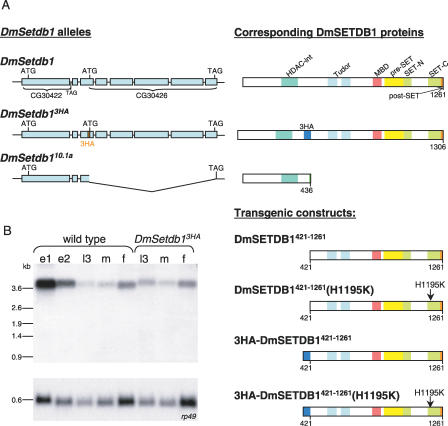
Schematic of the DmSetdb1 Alleles and Expression Profile of DmSetdb1 during Development(A) The structure of the DmSetdb1 gene is represented as well as the two alleles generated by homologous recombination. The gene was previously annotated as two entities, CG30422 and CG30426. DmSetdb13HA consists in a 3HA tag inserted in phase in the third exon. DmSetdb110.1a is a deletion removing amino acids 421 to 1,261 of the protein. The protein products of the three DmSetdb1 alleles and of transgenic constructs used in this study are also represented.(B) Analysis of DmSetdb1 expression by Northern blot in wild-type and DmSetdb13HA homozygous background at the indicated developmental stages: e1, 0–4-h embryos; e2, 0–18-h embryos; l3, third instar larvae; m, adult males; f, adult females. Membranes were hybridized with a probe spanning nucleotides 2,399 to 3,789 of DmSetdb1 ORF and with a RNA loading control probe recognizing the 0.6-kb rp49 transcript.